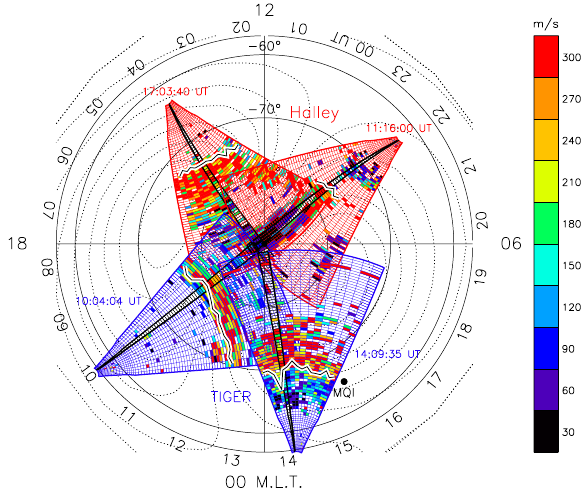
Fig. 1. Spectral widths recorded during two scans each of the Halley and TIGER radars mapped to co-ordinates consisting of MLT and AACGM latitude. Magnetic noon (12h) is at top, magnetic dawn (6h) to the right, and UT at TIGER is also indicated. Halley beam 8 and TIGER beam 4 are shown in bold black. The Halley full scans commenced at 11:16:00 and 17:03:40 UT, and the TIGER full scans commenced at 10:04:04 and 14:09:35 UT. Equipotentials given by the DMSP satellite-based Ionospheric Convection Model (DICM) (Papitashvili and Rich, 2002) for ( B x , B y , B z ) =(7, − 4, 2) nT are also superimposed (dotted). The minimum electric potential in the dusk cell is − 27.8kV, the maximum potential in the dawn cell is 5.5kV, and contours are separated by